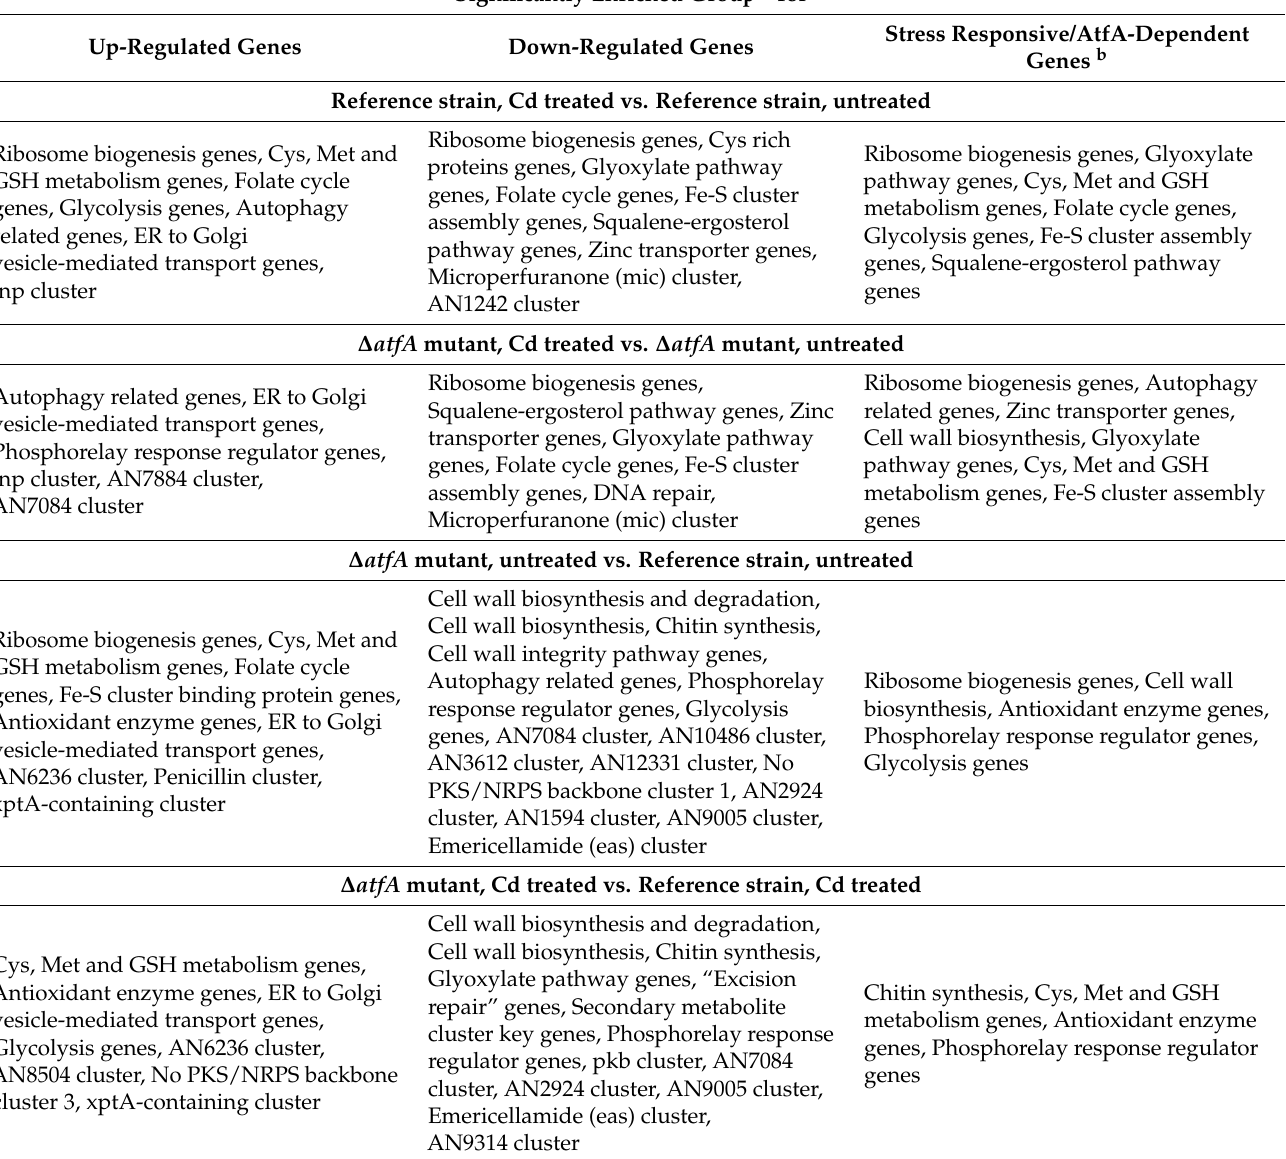
a —Table contains all the gene groups, defined in the Section 2.6. “Evaluation of RNAseq data” chapter, which were significantly enriched in the up-regulated and down-regulated gene sets. RNAseq data of the studied gene groups are available in Table S5. b —In the first two comparisons stress responsive genes, while in the last two comparisons AtfA-dependent genes were studied. In the case of secondary metabolite cluster genes, enrichment was studied only in the up-regulated and down-regulated gene